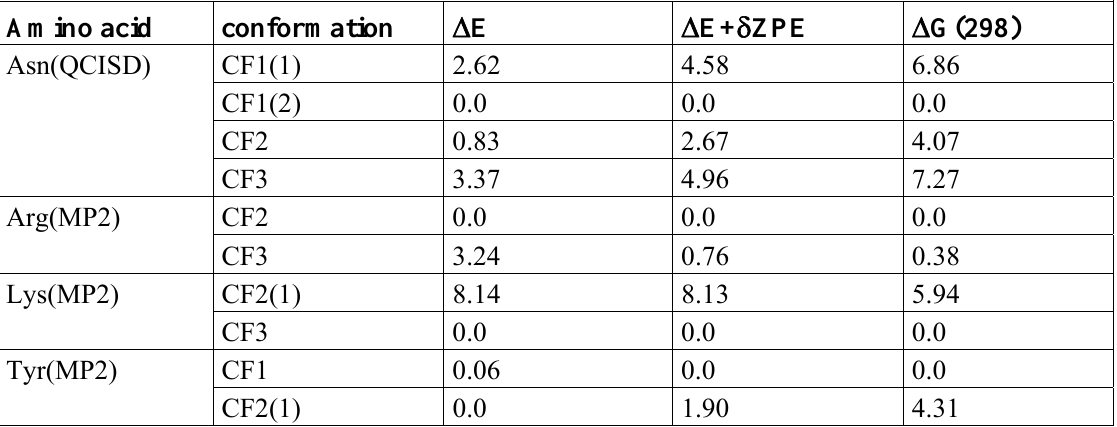
Table 6: Relative stabilities of some low-lying conformations for Asn, Arg, Lys and Tyr, expressed by the internal energy difference ∆ E at the QCISD or MP2 level, by the ∆ E incremented with the zero point energy difference ∆ E+ δ ZPE, and by the Gibbs free energy ∆ G calculated at 298 K. All energies are in